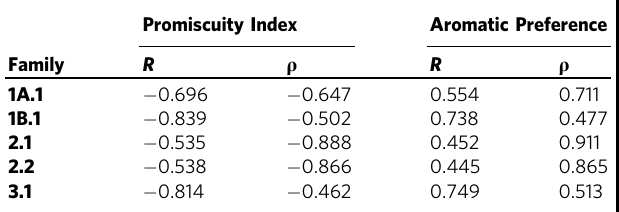
Table 1 Correlations between overall catalytic activity and speci fi city for each ribozyme family (Pearson ’ s R and Spearman ’ s ρ ; n = 1954, p -values < 10 − 95 in each case (two-